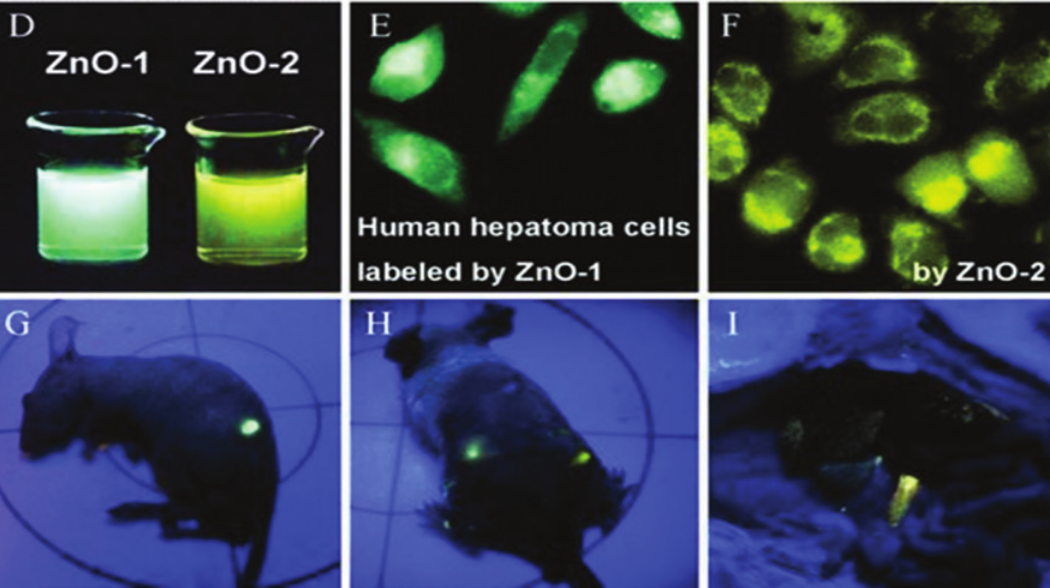
Figure 8: Photoluminescence of ZnO NPs under UV light (D), luminescence of ZnO inside the cell (E, F), and mice model (G–I) (adopted from Xiong)